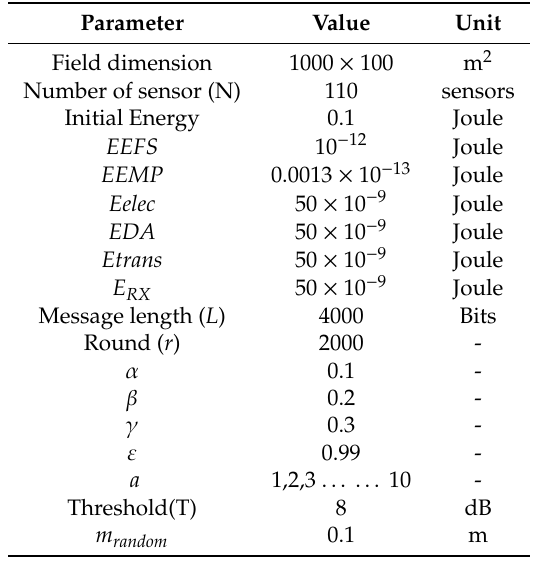
Table 2. Simulation parameters of the proposed LEACH protocol.